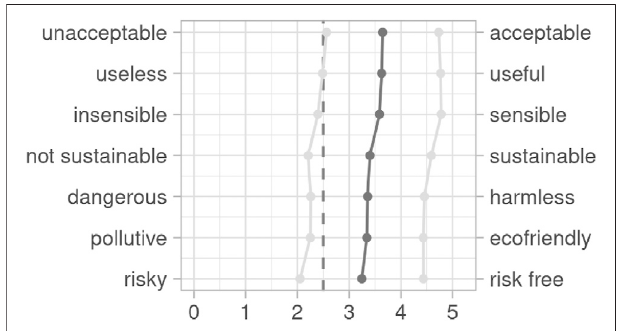
FIGURE 5 | The affective evaluation of CCU insulation boards ( N (cid:1) 643). The dark line indicates the mean evaluation and the lighter lines the standard deviation to both